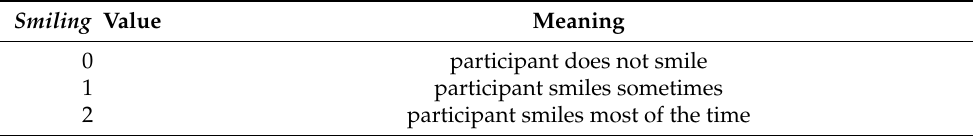
Table 3. Annotation of smiling .